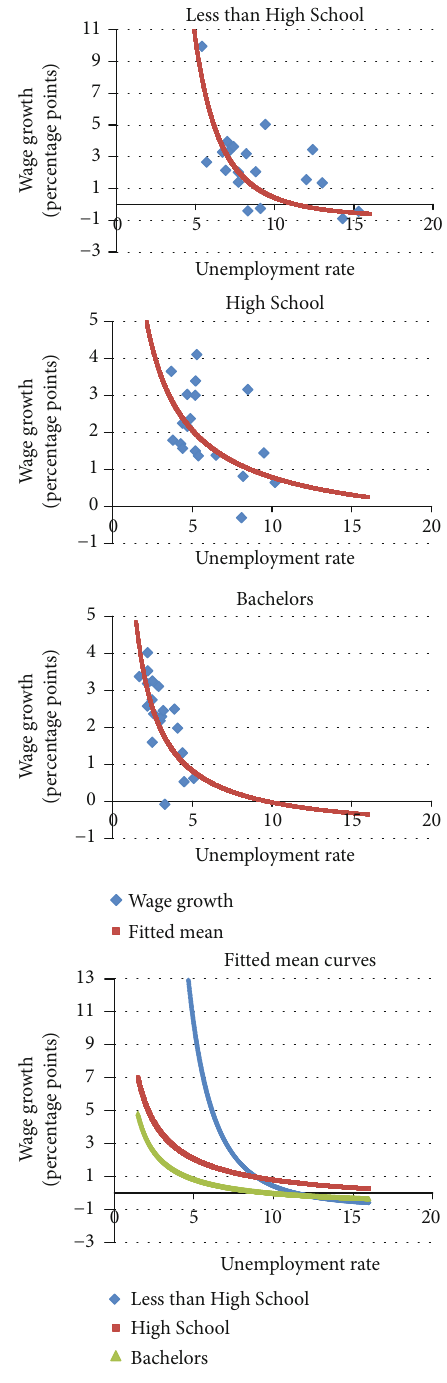
Figure 1: Visualization of fi ts of the three data sets to Equation (12) using the mean of each parameter ’ s posterior